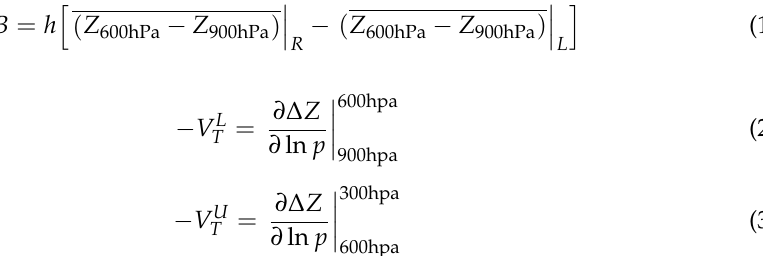
The black solid rectangle indicates the initial domains for the control and SST4.5 simulations. The black and red dashed rectangles indicate the final location of D3 in the control and SST4.5, respectively. ( b ) The minimum central pressure in simulations (black solid line for the control and red solid line for SST4.5; hPa; 1 h interval) and best track data (green solid line; hPa; 3 h interval; CMA) and maximum 10 m wind in simulations (black dashed line for the control and red dashed line for SST4.5; m s − 1 ; 1 h interval) and best track data (green dashed line; m s − 1 ; 3 h interval;